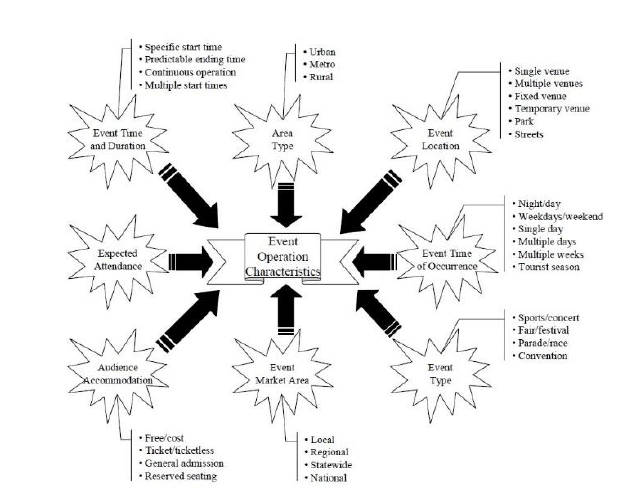
Figure 2. Planned Special Events operation